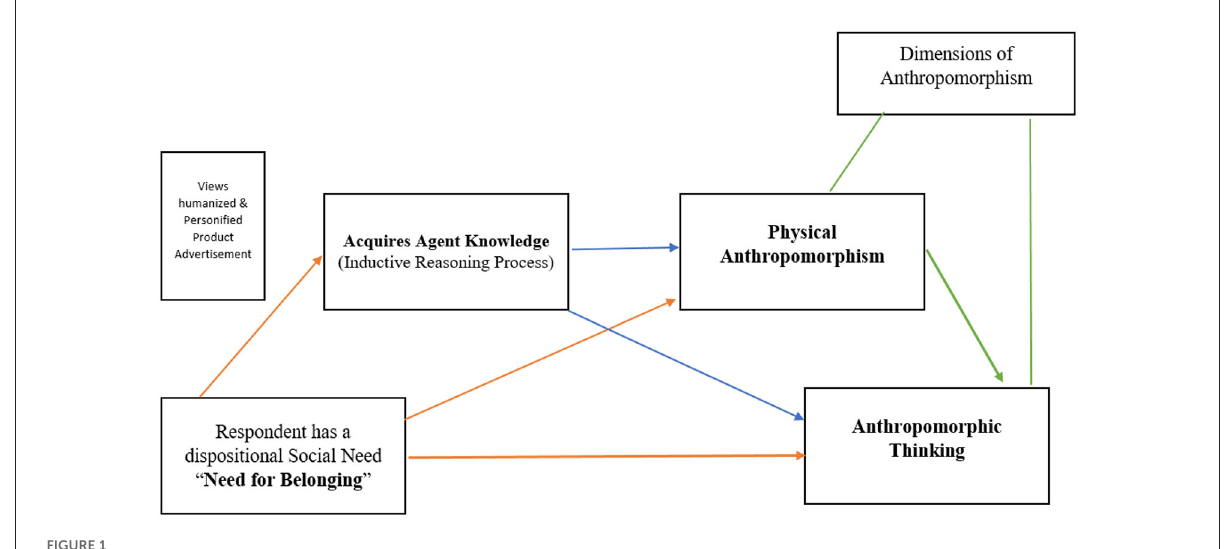
FIGURE1 Inter-relationship between